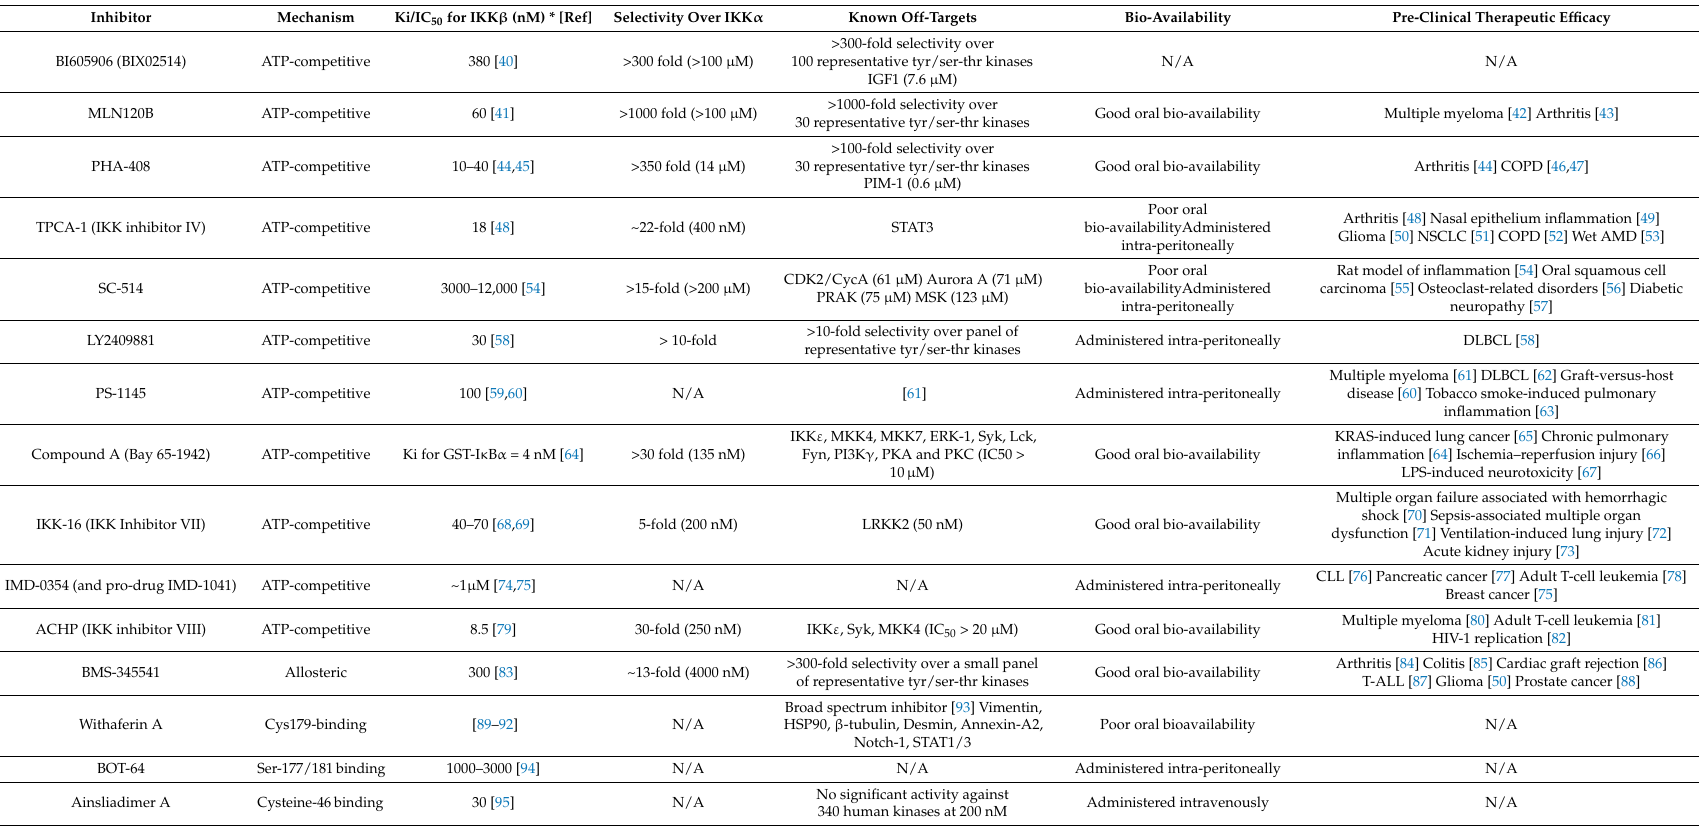
Table 1. Commercially available IKK β